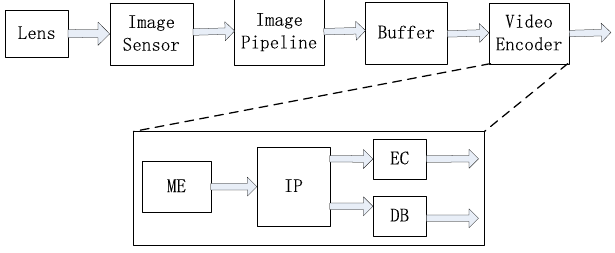
Figure 2. Data flow for a video-acquisition system mainly including an image sensor, an image processing pipeline and a video encoder for video